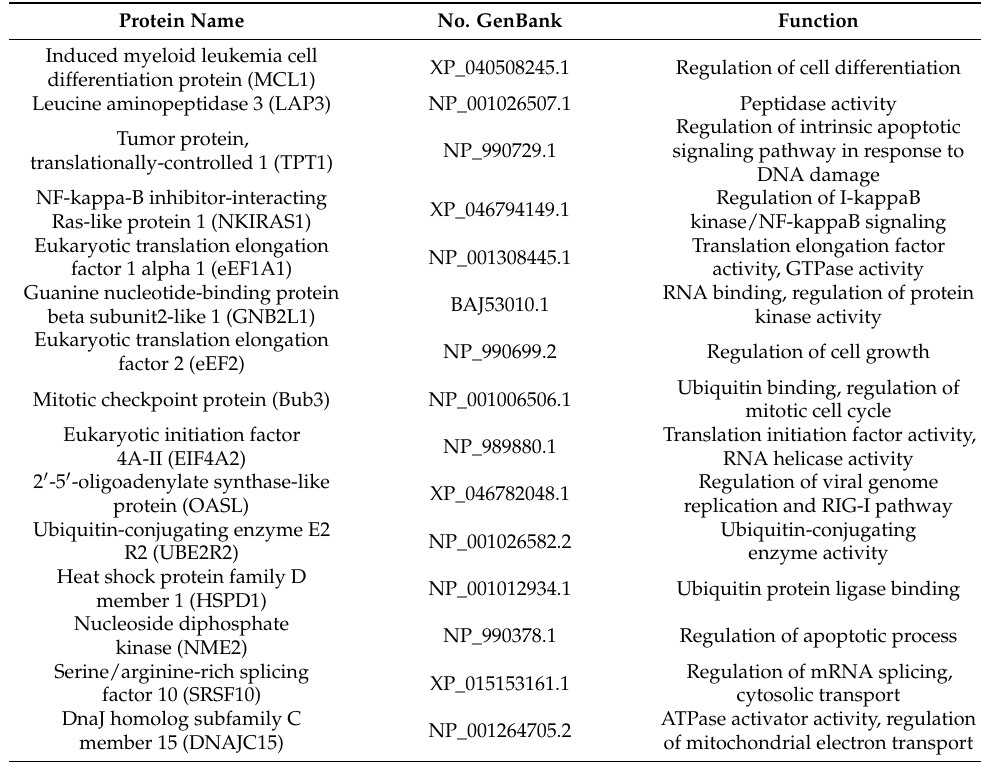
Table 1. The screening result of chicken spleen cDNA using ARV